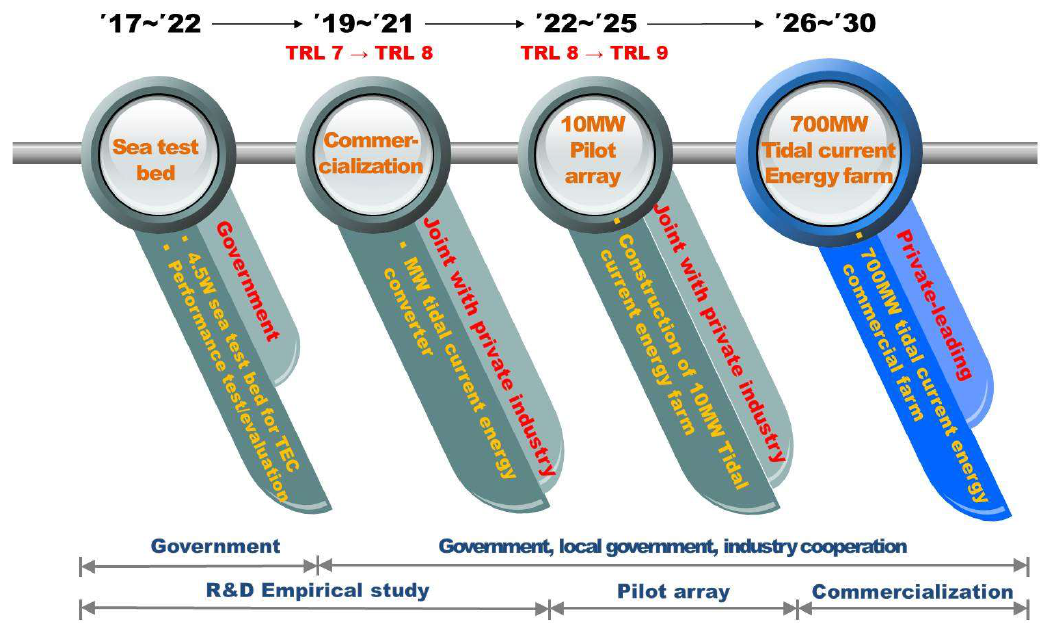
Figure 4. 2030 planning for the development of tidal current energy [10,11].